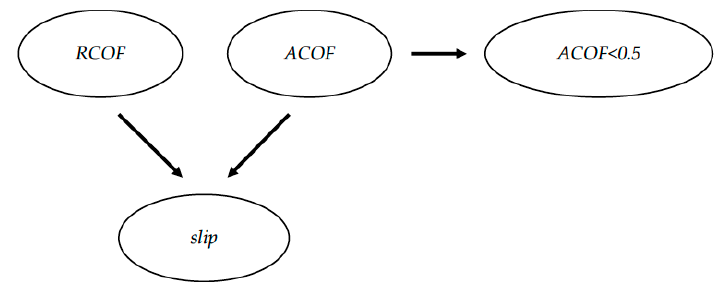
Figure 2. Hybrid Bayesian network developed for a slip event based on the ACOF and the RCOF.